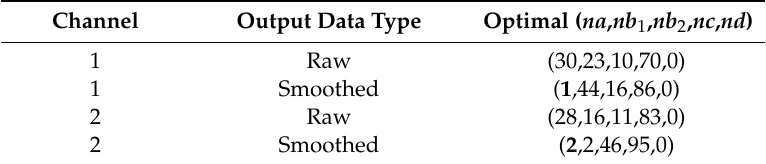
Table 5. Optimal structural indices for ARMA models on both channels, in case of one-step optimization strategy.